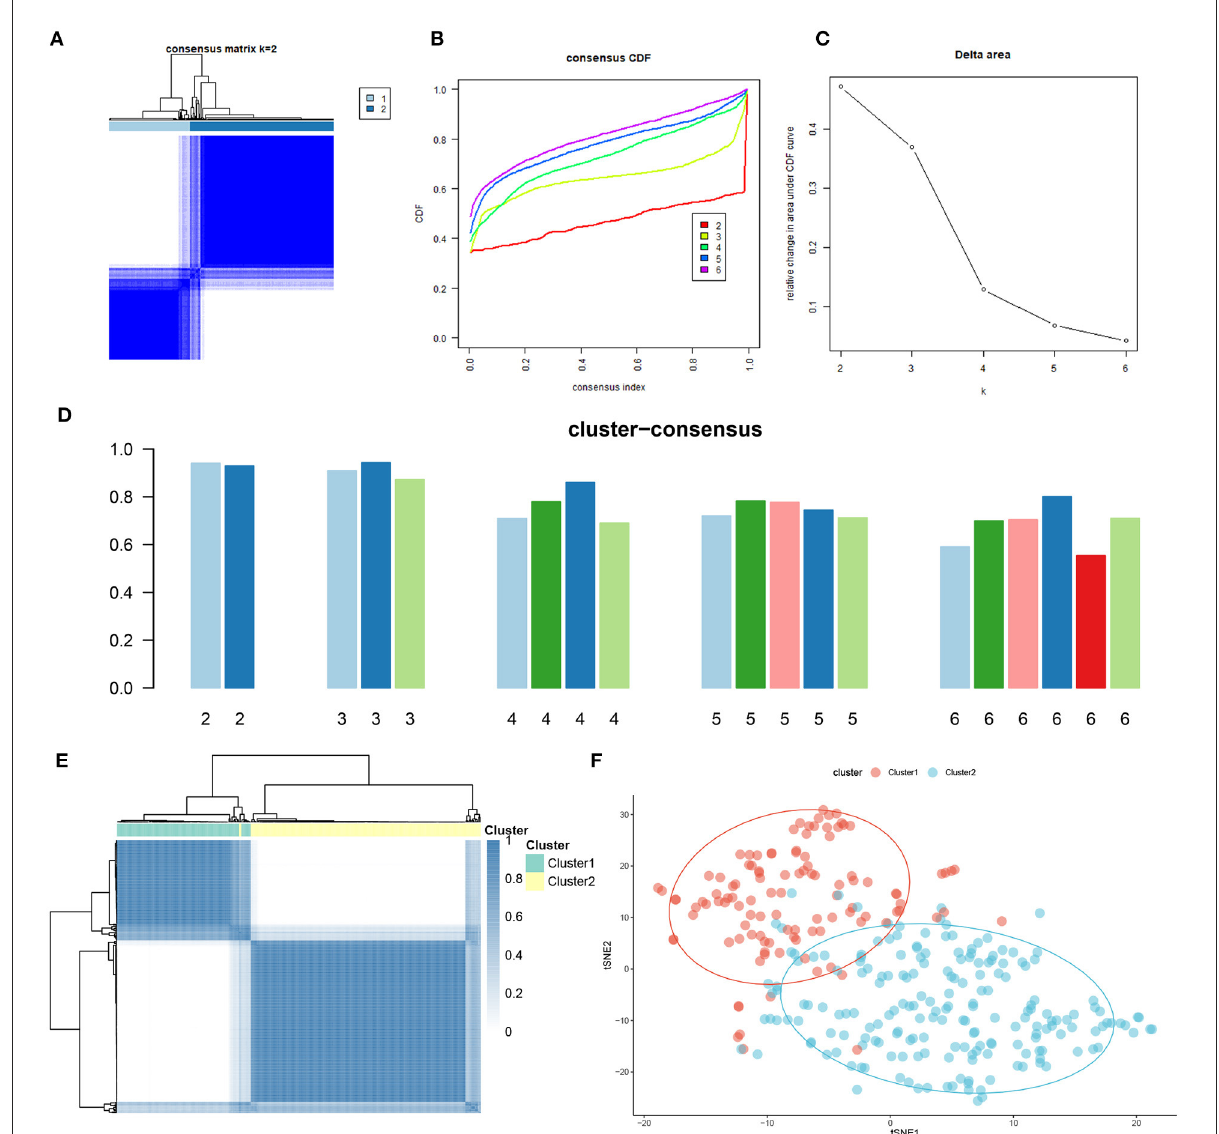
FIGURE3 Identification of cuproptosis-related molecular clusters in AD. (A) Consensus clustering matrix when k = 2. (B–E) Representative cumulative distribution function (CDF) curves (B) , CDF delta area curves (C) , the score of consensus clustering (D) , and heatmap of non-negative matrix (E) . (F) t-SNE visualizes the distribution of two